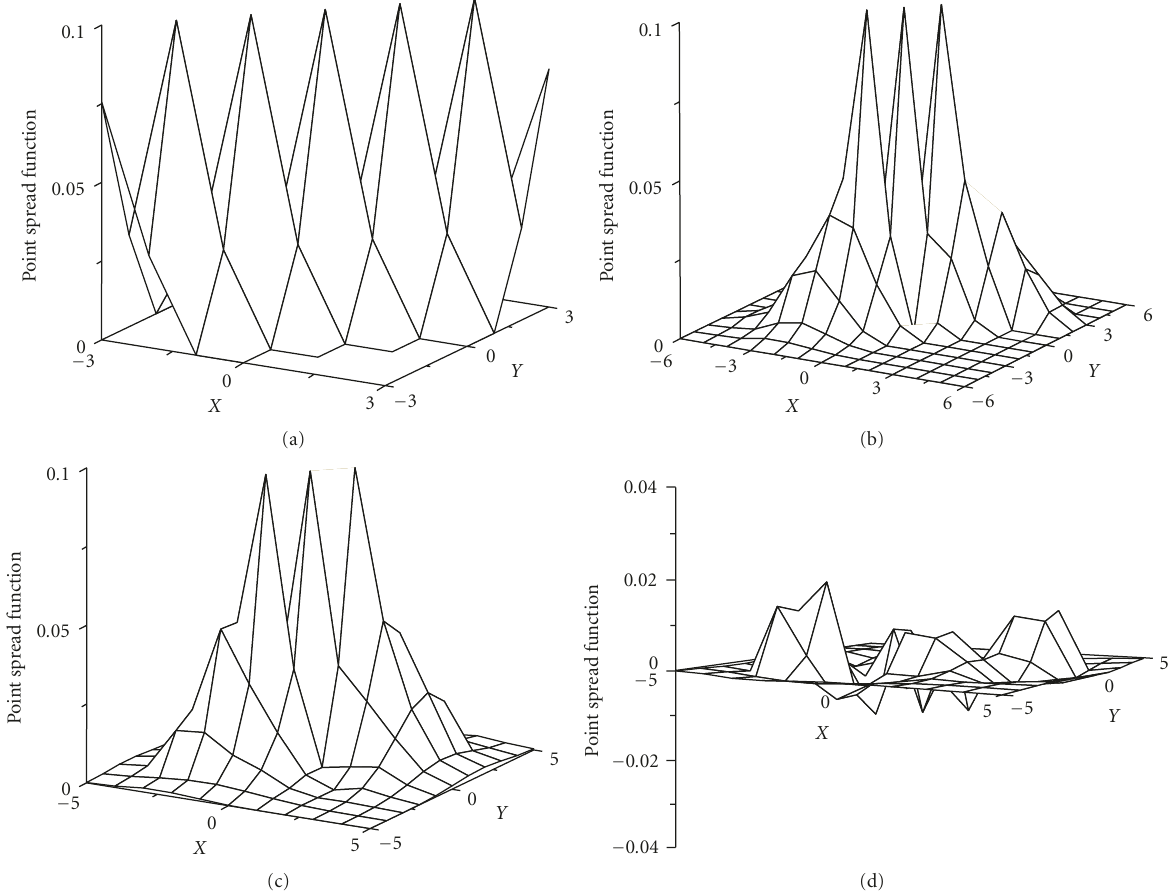
Figure 10: PSF estimation results using Airplane image and the sample PSF in Figure 9(a). (a) Initial PSF estimated by [7]. (b) Estimated